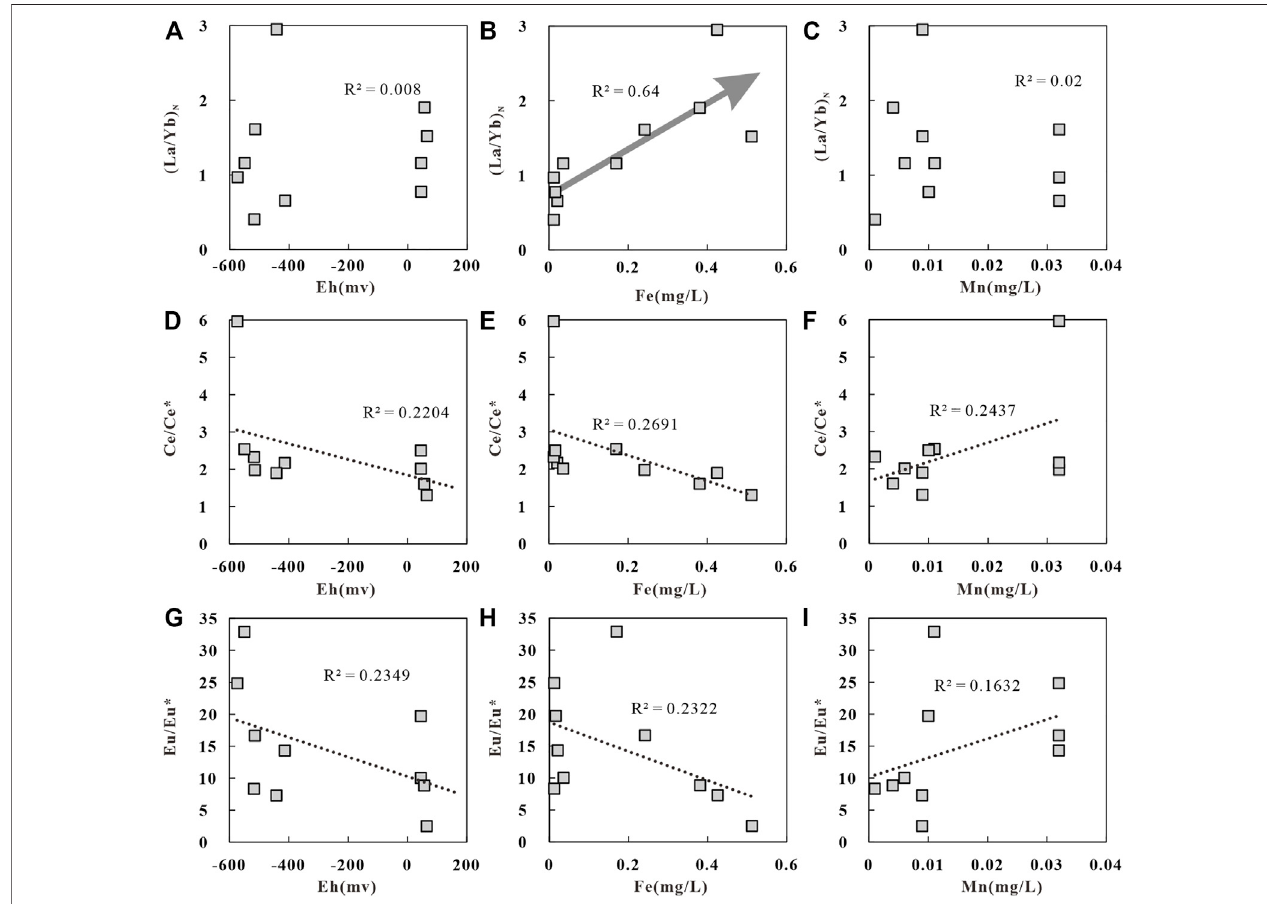
FIGURE 9 | Correlation of geothermal water in the study area, (A) (La/Yb) N versus Eh, (B) (La/Yb) N versus, (C) (La/Yb) N versus Mn, (D) Ce/Ce* versus Eh, (E) Ce/ Ce* versus, (F) Ce/Ce* versus Mn, (G) Eu/Eu* versus Eh, (H) Eu/Eu* versus, (I) Eu/Eu* versus Mn.